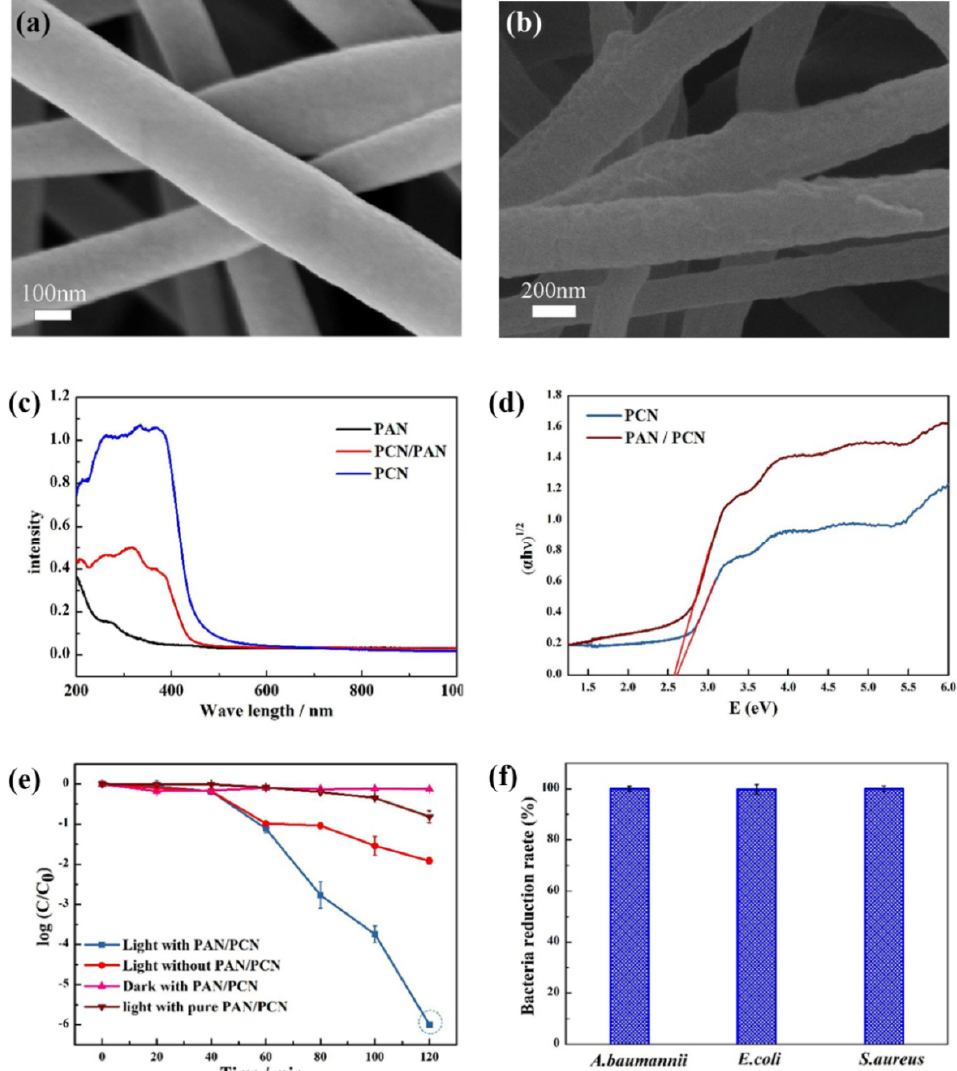
Figure 13. ( a , b ) SEM images of pure PAN ( a ) and PAN/g-C 3 N 4 composite ( b ) fabrics. ( c ) UV–Vis diffuse reflectance images of PAN fabric, PAN/g-C 3 N 4 (PAN/PCN) composite fabric, and g-C 3 N 4 (PCN). ( d ) Plots of converted Kubelka–Munk functions versus light energy of g-C 3 N 4 (PCN) and PAN/g-C 3 N 4 (PAN/PCN) composite fabric. ( e ) Photocatalytic disinfection of Staphylococcus aureus . ( f ) Percentage of disinfection efficiency of Acinetobacter baumannii , Escherichia coli , and Staphylococcus aureus . Reprinted with permission from [47]. Copyright 2020, Elsevier.